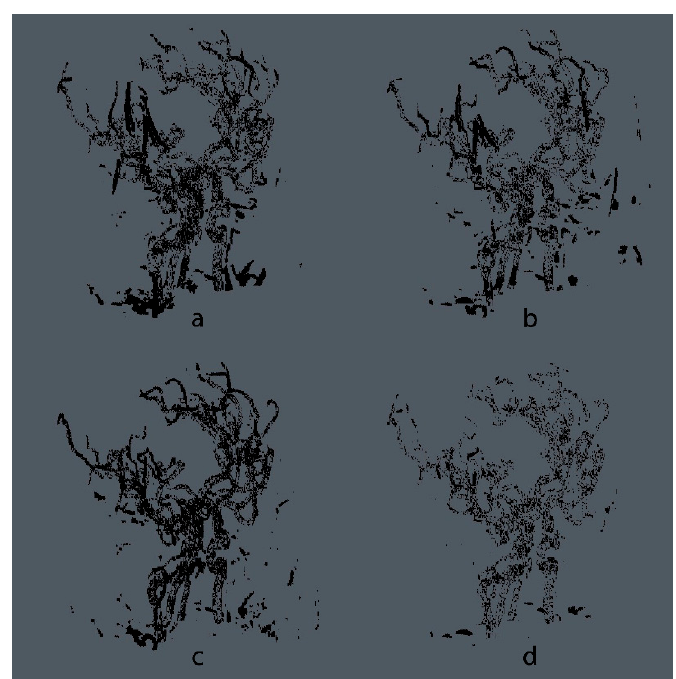
Figure 7. Segmentation map obtained from each one of the evaluated methods described in Table 2, using data from the first fold of the cross-validated experiment. 3D Visualizations were generated by the software Aliza Medical Imaging ©, Bonn, Germany, and DICOM Viewer for ground truth and prediction volumes. ( a ) Ground truth, ( b ) U-Net [22], ( c ) Pix2Pix [33], ( d ) Concatenated U-Net and residual U-Net [30], and ( e ) Proposed cGAN.